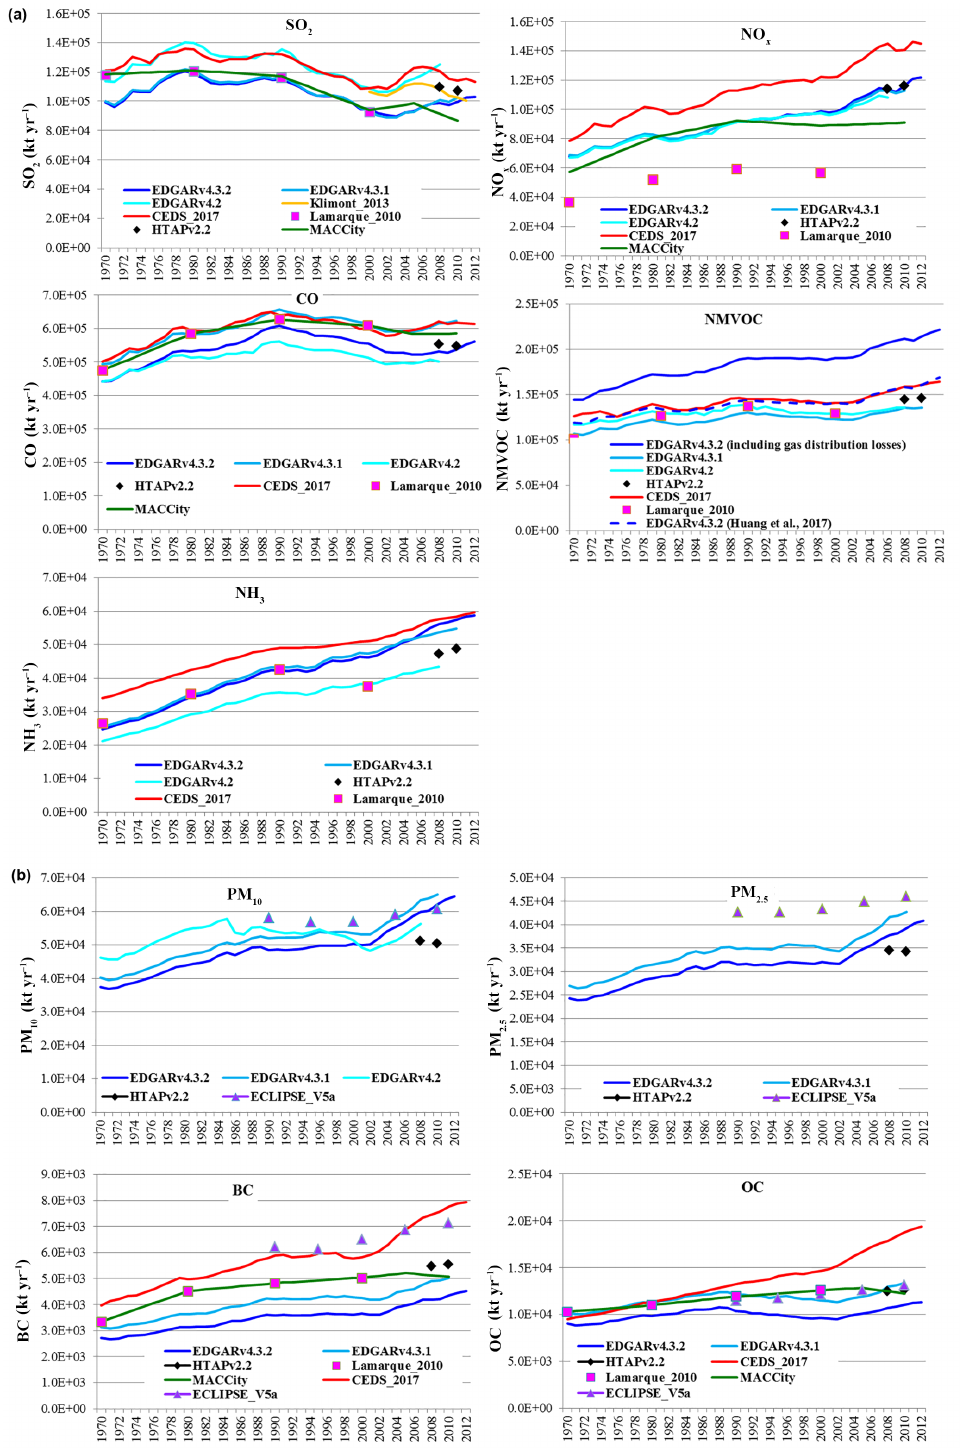
Figure 5. (a) Comparison of the global emission time series (1970–2012) of gaseous pollutants provided by different global emission inventories. The NMVOC graph presents two estimates for the EDGAR v4.3.2 database, one referring to the work of Huang et al. (2017) and the second one related to this study, which also includes the emissions from the gas distribution losses. (b) Comparison of global